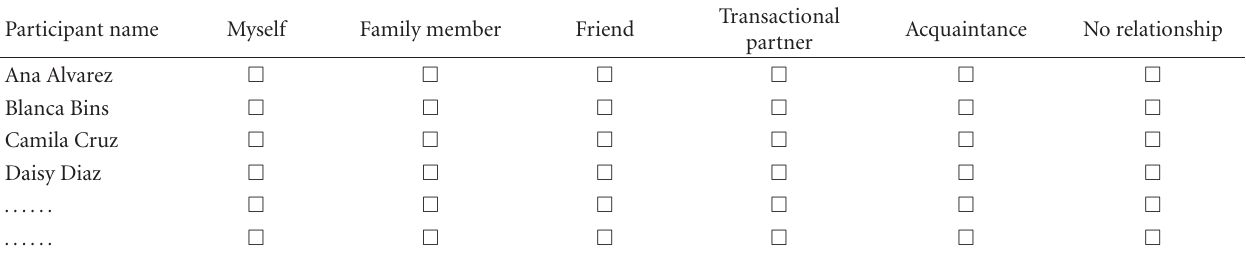
Table 6: Please place a check in the box next to each name describing the relationship you have with that person. For each name, indicate only your relationship and leave all other options for that person